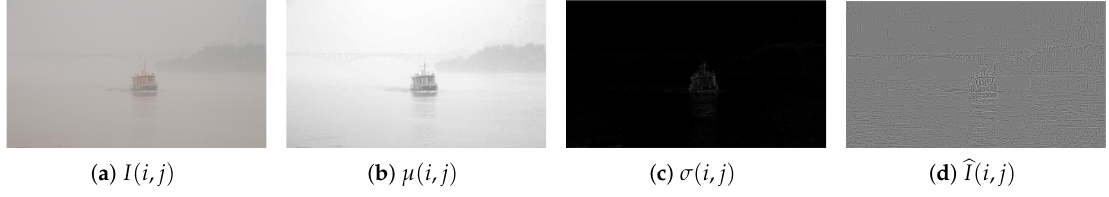
Figure 4. Examples of mean substracted contrast normalization (MSCN) coefficient.